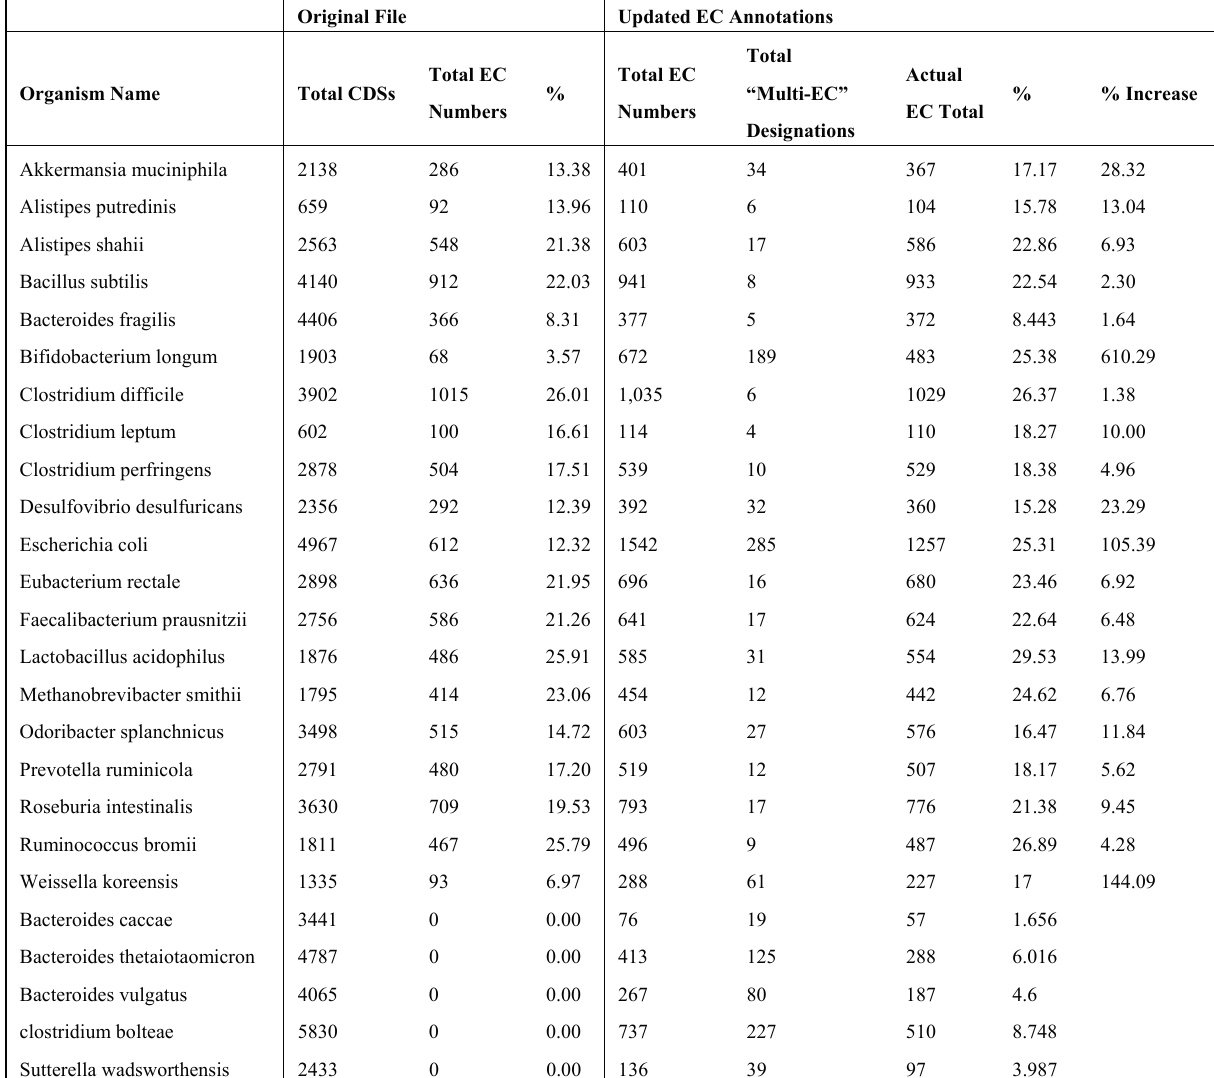
Table 12. GenBank file statistic comparisons between the number of EC number annotations and coding sequences